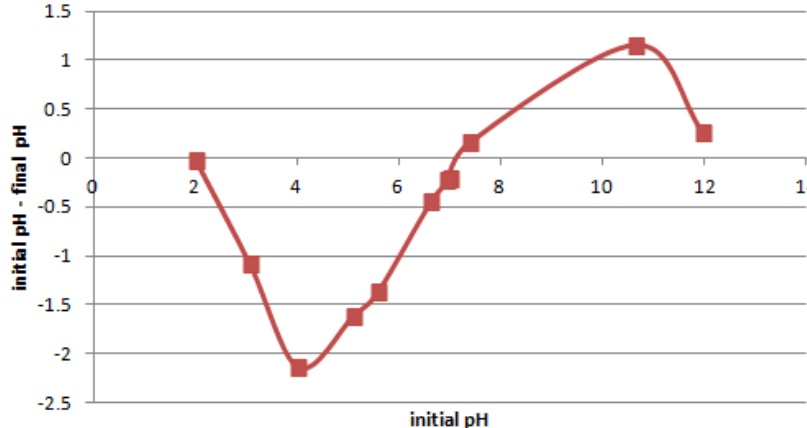
Figure 7. The pH change vs. initial pH for pH zpc determination.